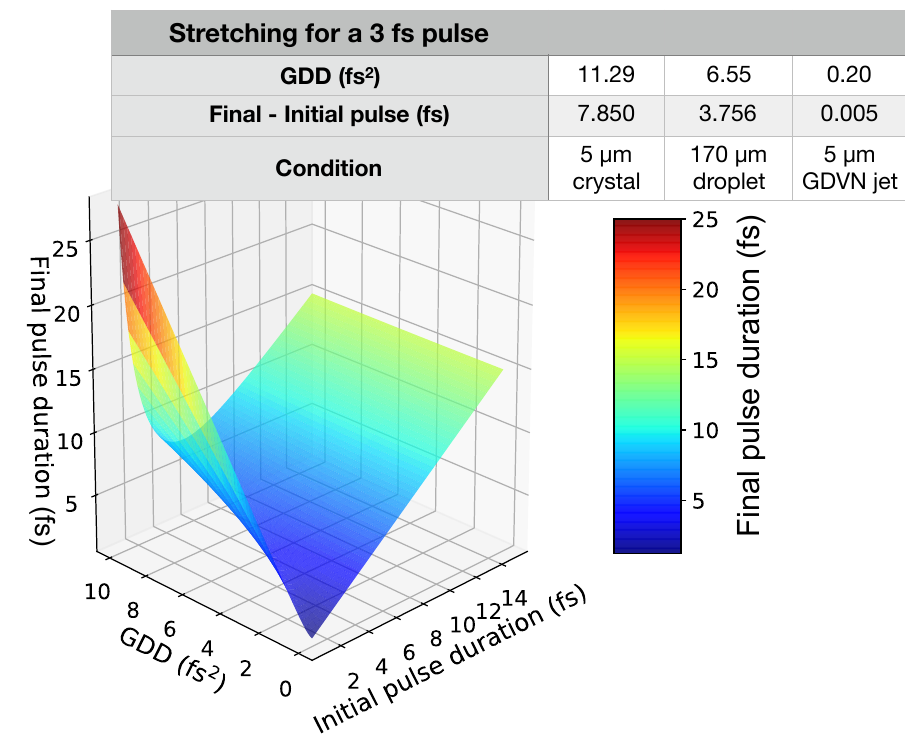
Figure 9. Chromatic dispersion effect. Calculated stretching of a femtosecond optical pulse given a range of group dispersion delay (GDD) values. The table shows stretching values for a 5- µ m GDVN jet (GDD = 0.20 fs 2 ), a 170- µ m droplet (GDD = 6.50 fs 2 ), and a 5- µ m crystal (GDD = 11.29 fs 2